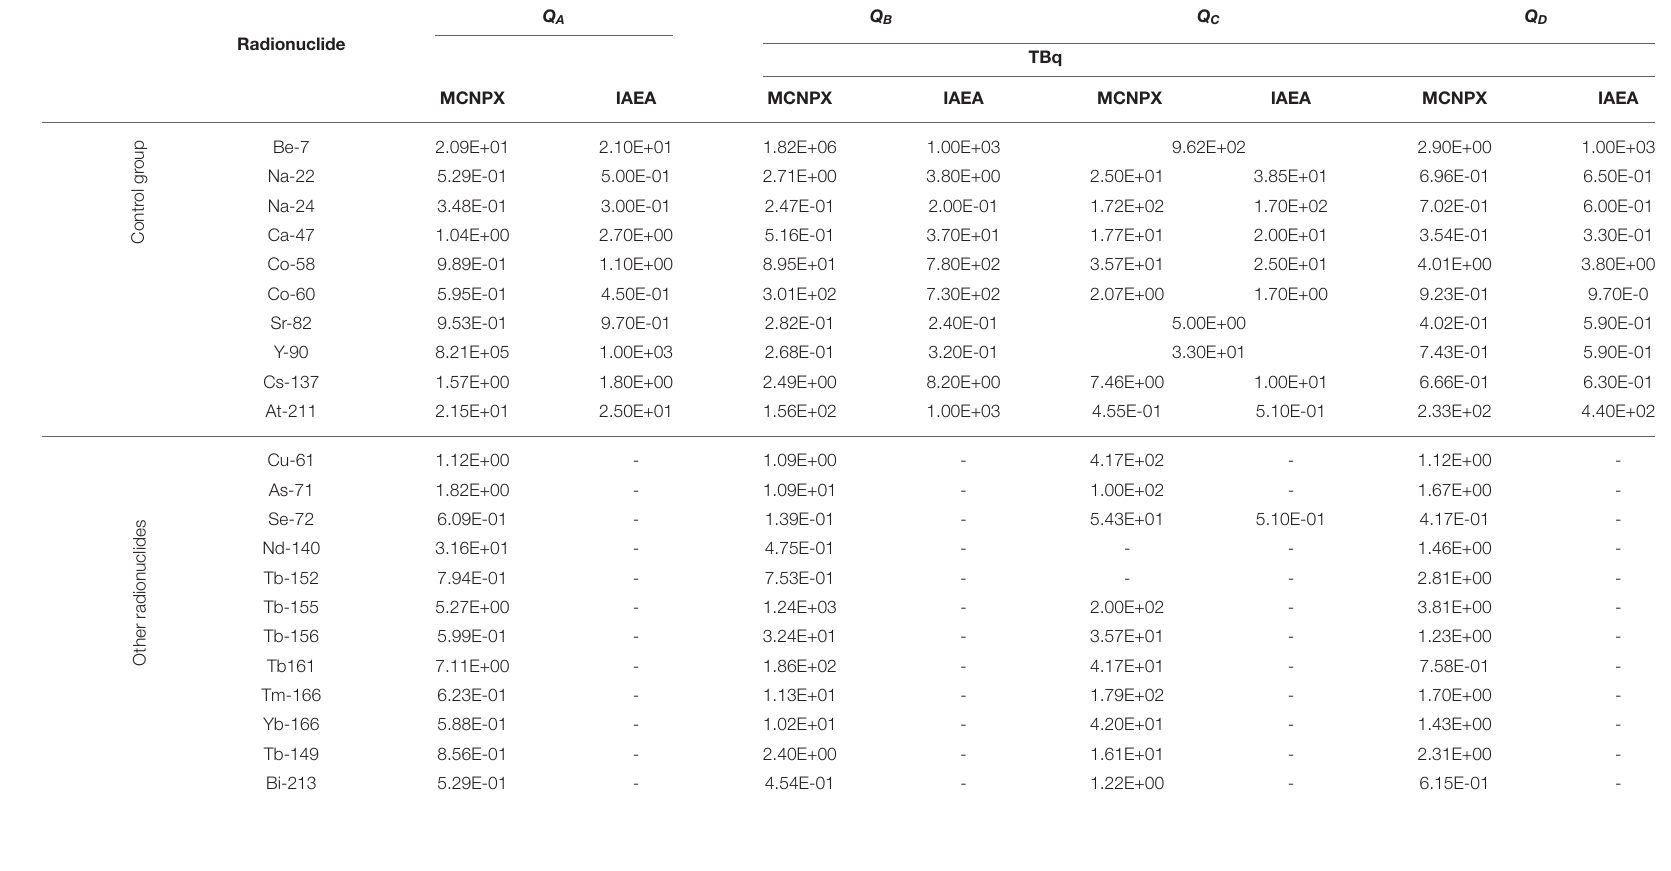
TABLE 3 | Results of the Q values obtained using the simulated dose rate coefficients and the ones listed in the IAEA Safety guide (4).